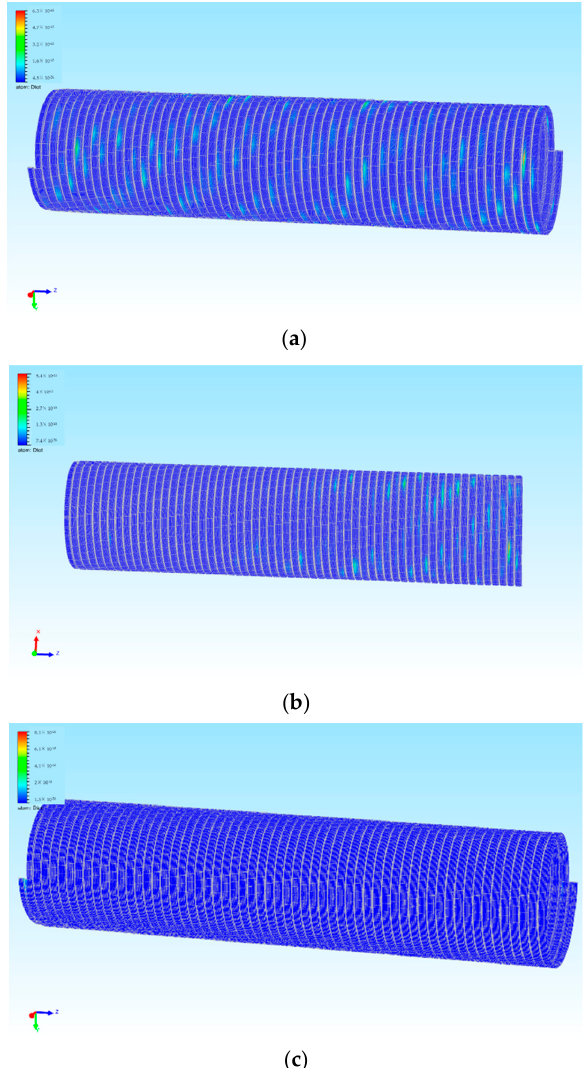
Figure 11. Fatigue damage of the skeleton layer. ( a ) The fatigue damage nephogram under axial compressive load; ( b ) The fatigue damage nephogram under bending moment; ( c ) The fatigue damage nephogram under torsion.